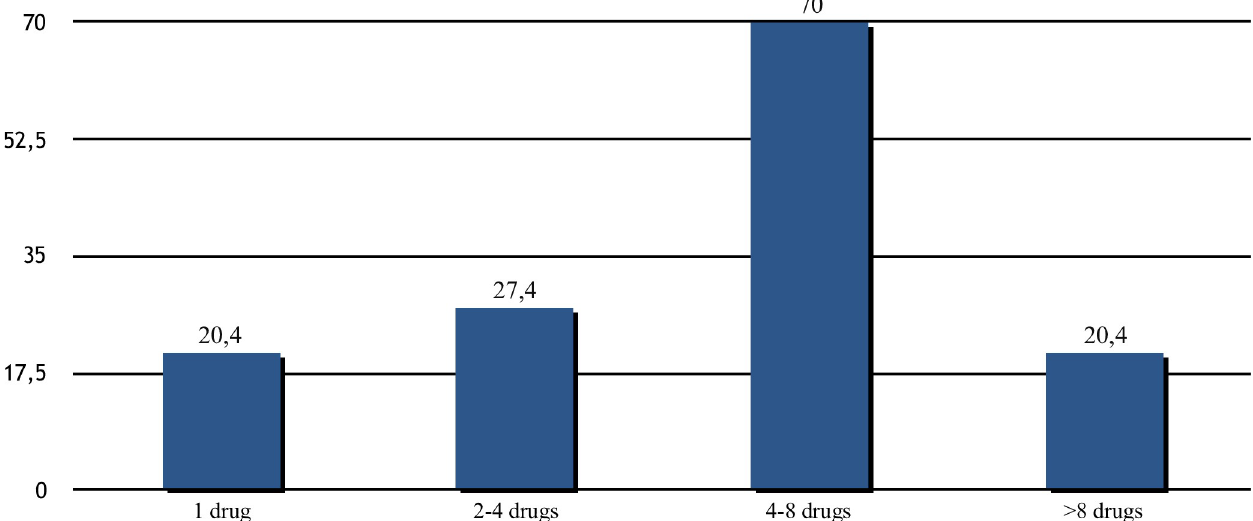
Fig 3. SVR12 overall and by baseline characteristics. SVR12 were extremely high regardless of baseline characteristics of patients including fibrosis stages, HCV genotypes and key populations including PWID.